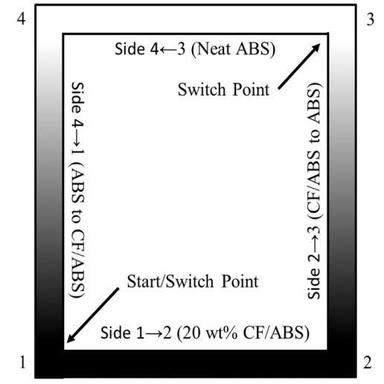
Rectangular geometry printed on BAAM – B showing transition points and blended regions.